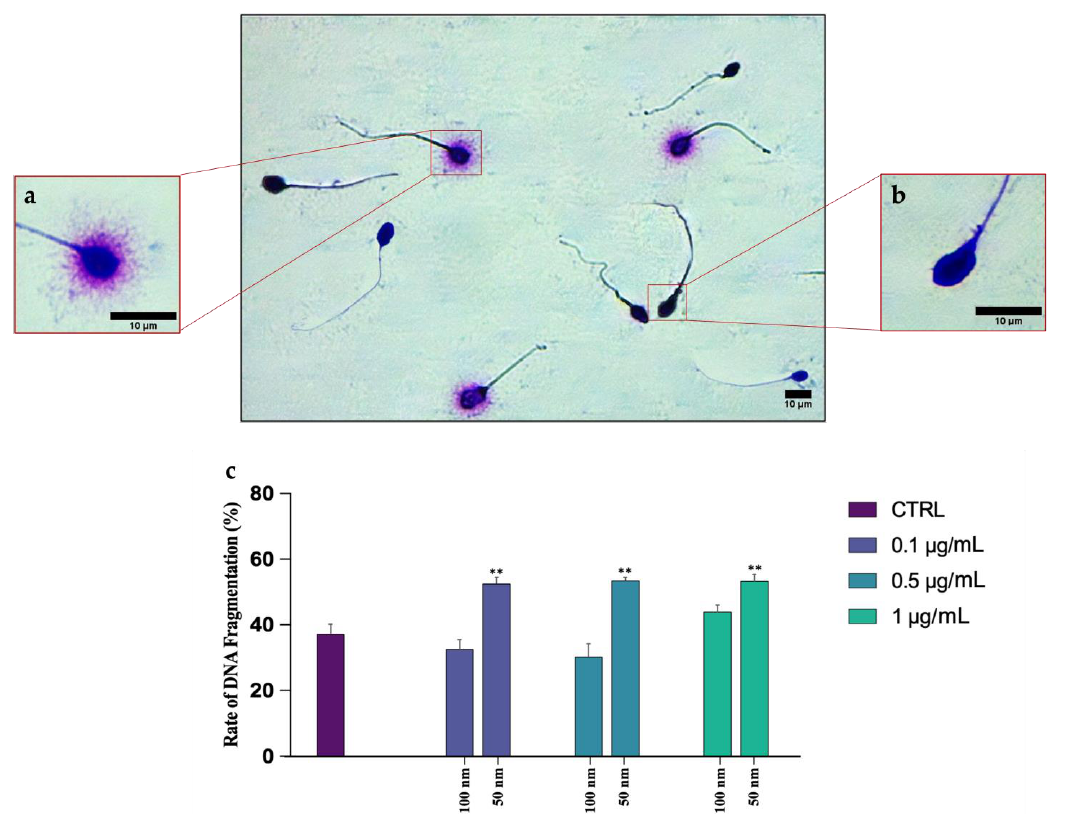
Figure 3. Mean percentage of spermatozoa with acrosome damage after exposure (30 min) to 50 and 100 nm PS-NPs with increasing concentrations. Approximately 400 spermatozoa were counted in five different fields for each sample. In addition, two replicates were performed, in a total of 8 samples and 3200 spermatozoa analyzed. Significant data have been found at the higher concentration of both PS-NPs (* p < 0.05).